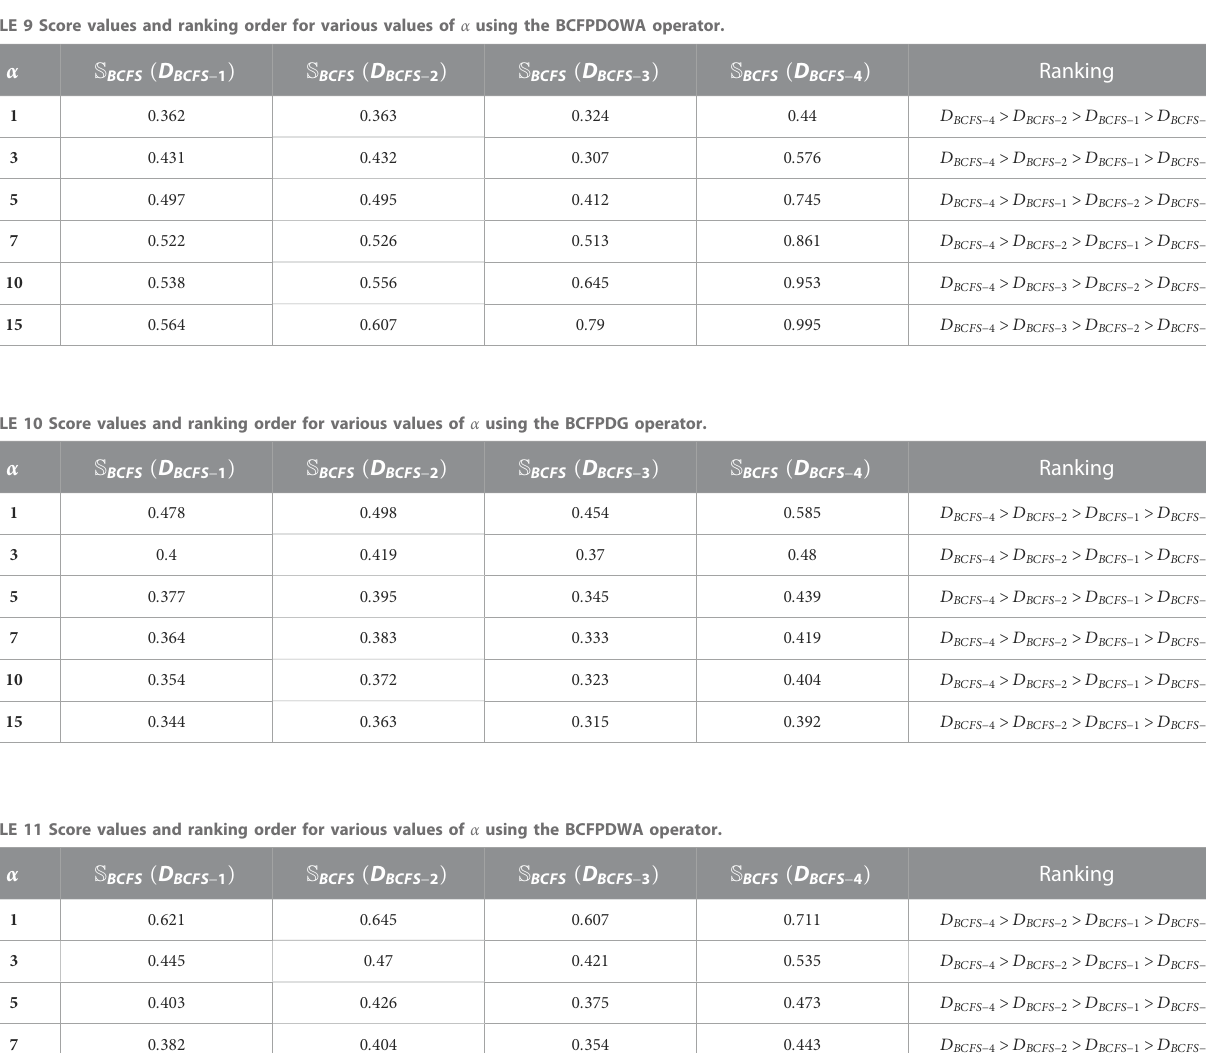
TABLE 9 Score values and ranking order for various values of α using the BCFPDOWA operator. α